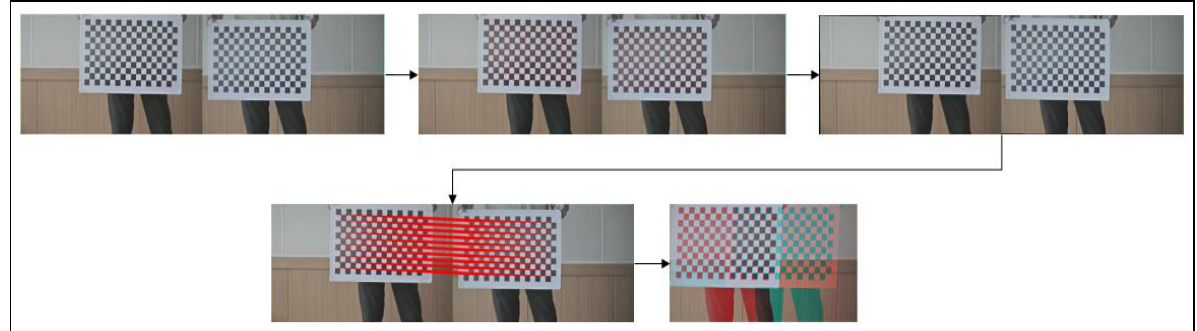
Figure 2. The process from camera calibration to rectification using a checkerboard.